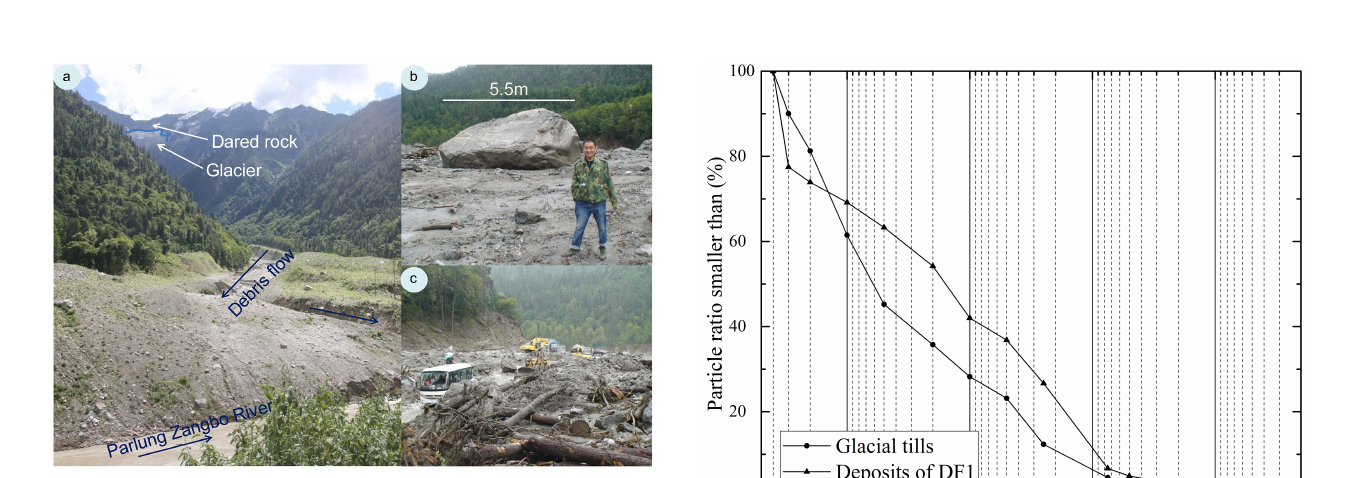
Figure 3. DF1 in 2007 (a) Overview of the Tianmo debris flows from the downstream area; (b, c) Boulder and debris flow deposits on the northern side of the Parlung Zangbo River).